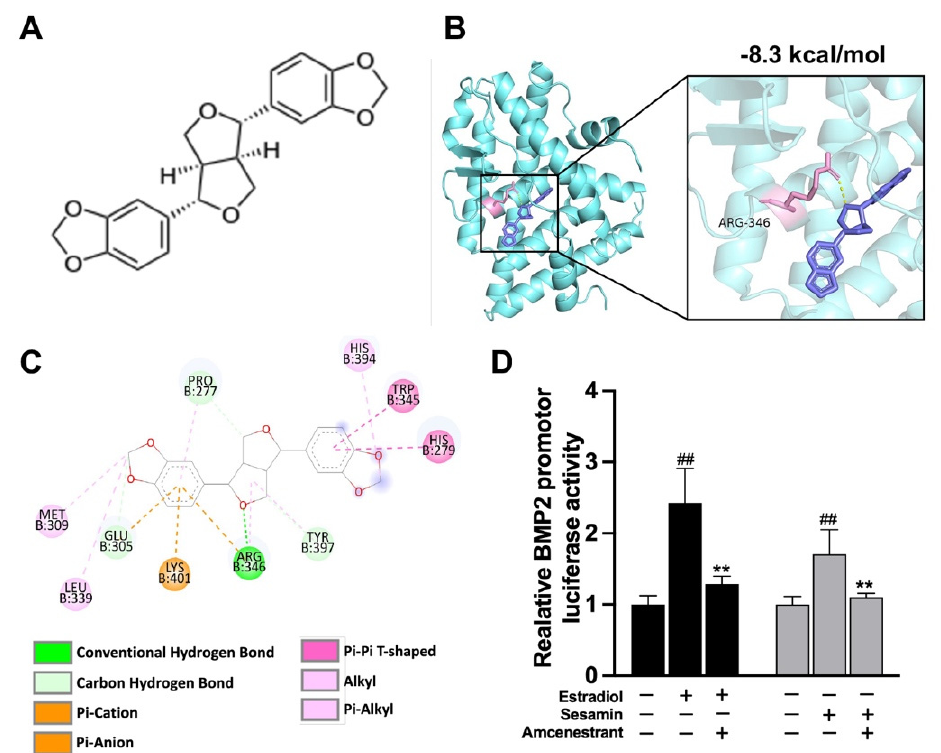
Figure 1. Sesamin exhibited high binding affinity to Er α : ( A ) Molecular structure of sesamin. ( B ) Three-dimensional structure of the predicted interaction structural model between sesamin and the ligand binding pocket of ER α . Sesamin was violet colored. Side chains in ER α were pink colored ( C ) Predictions of various binding forces between sesamin and residuals of ligand binding pocket of ER α . ( D ) Luciferase activity of BMP2 promotor reporter system upon treatment of sesamin, estradiol and ER α inhibitor amcenestrant in vitro ( n = 6; ## p < 0.01 vs. NC group; ** p < 0.01 vs. non-amcenestrant treatment group).